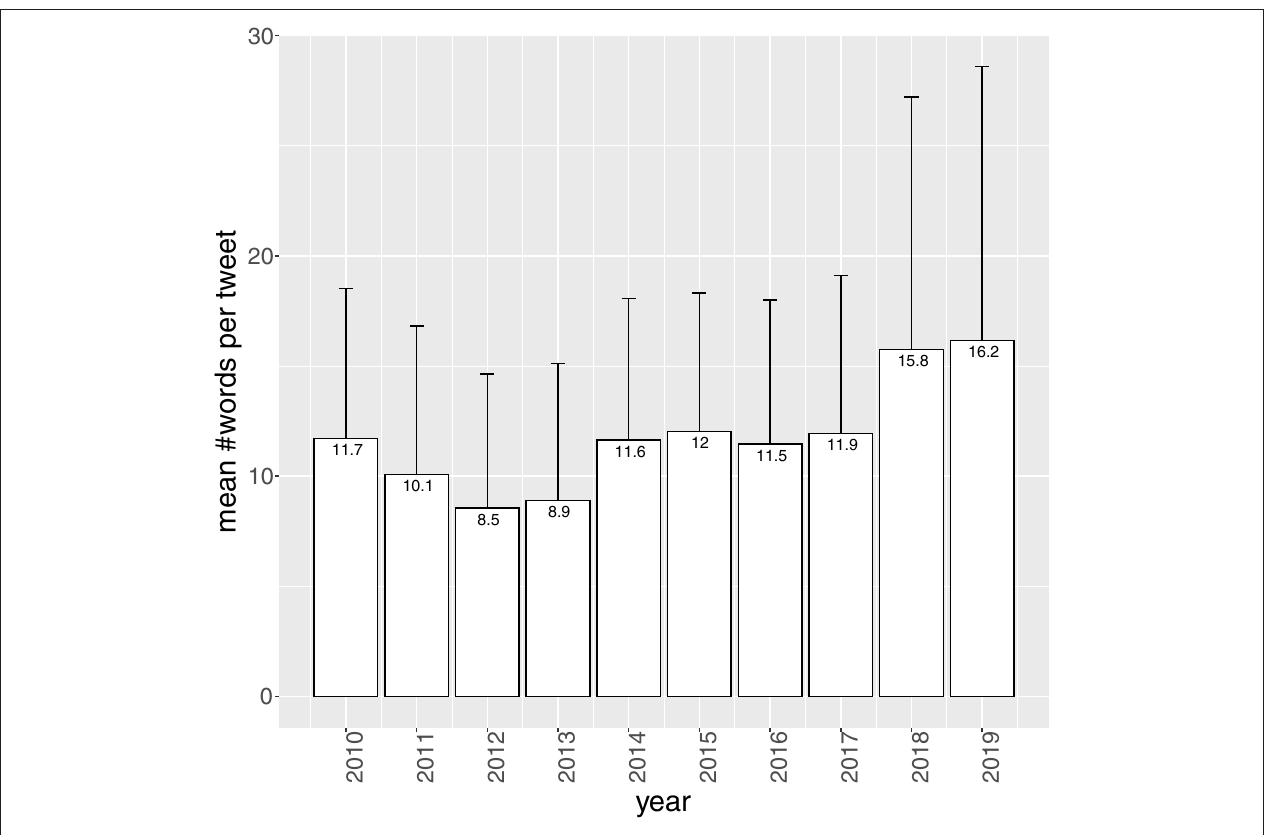
FIGURE 4 | Mean number of words per tweet (averaged over Twitterers), split up by year ( n = 698,369, N = 186).